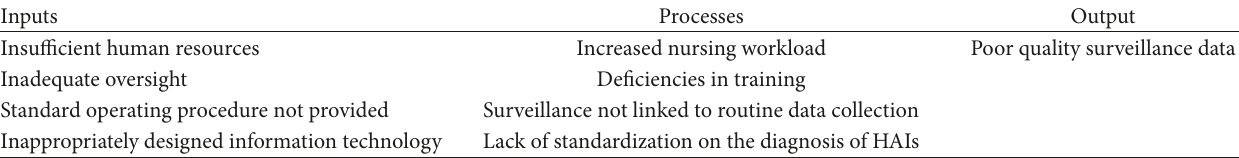
Table 2: Summary of challenges in the implementation of the HAI surveillance